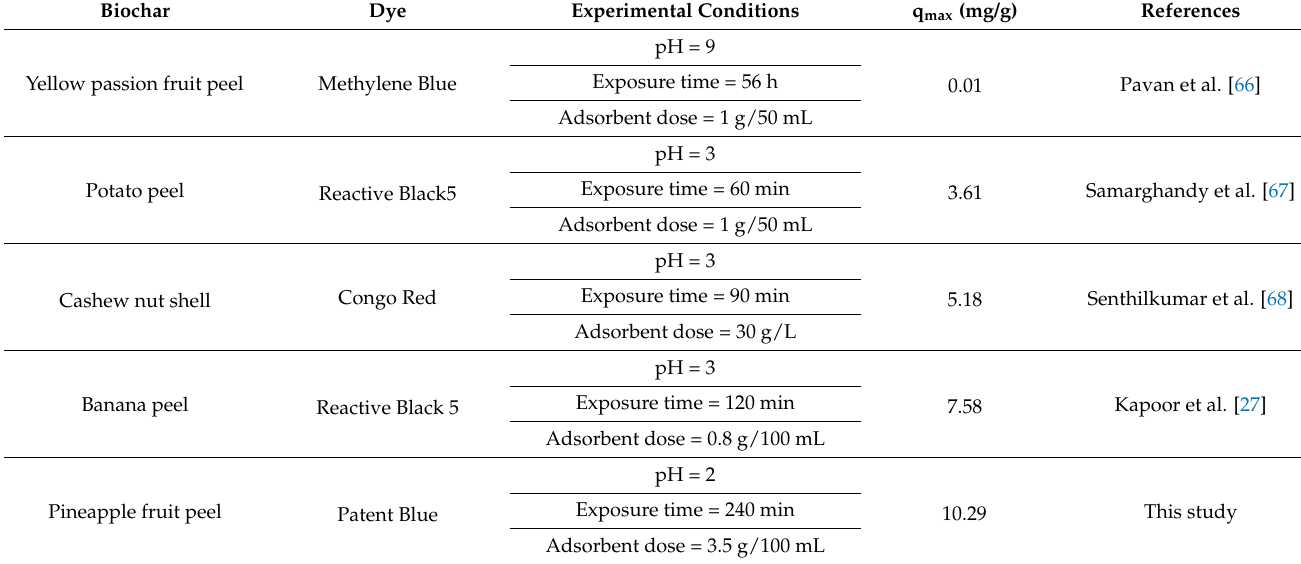
Table 7. Uptake capacity of dye with different